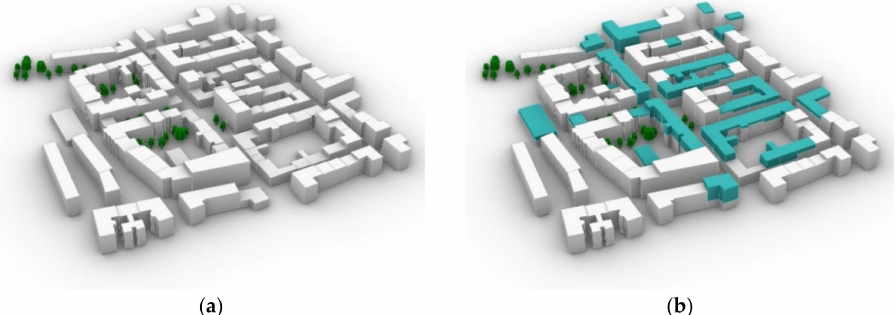
Figure 2. 3D model of the study domain: ( a ) base case; ( b ) densification scenario (depicted in cyan